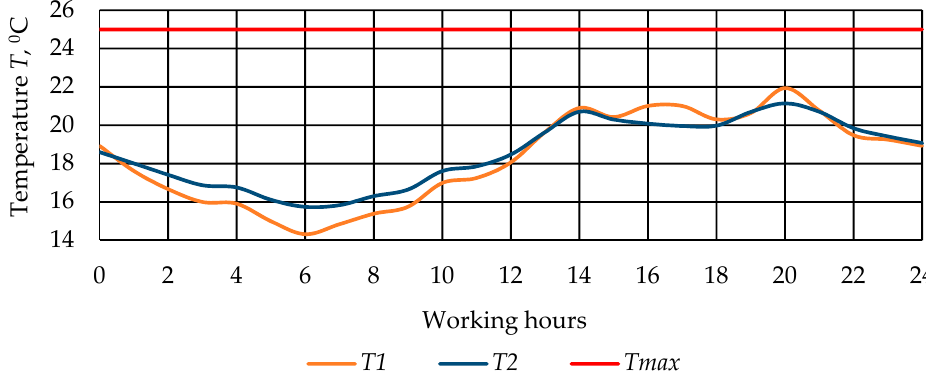
Figure 8. Temperature dynamics on a moderate day (maximum temperature of 21.9 °C ).